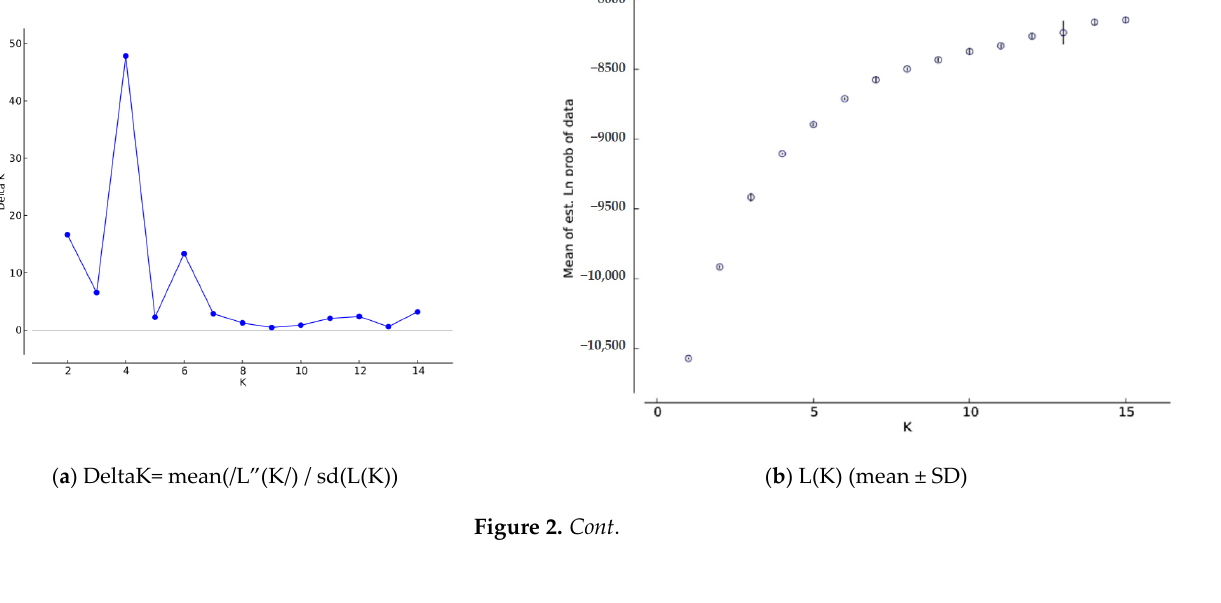
Figure 2 . Detecting the most likely number of genetically distinct groups within yellow-bellied toads in the northern Weser Hills based on ( a ) mean L(K) ± SD over 20 runs per K, ( b ) Maximum likelihood estimation of K [30] and ( c ) percentage of population assignment of K = 4. Each individual is visualized as a single line. Coloration indicates the membership of the individual to the given cluster (“G”). G1 (orange) = FL, WW, NS, BO, SM, MB. G2 (green) = WE, LI, JW, BE, RO, SH. G3 (blue) = BM, BH. G4 (purple) = PA. G4 was very clearly demarcated against all other clusters, with PA being the only study site within this cluster. LI and other study sites around Bückeberg showed no dis- tinct separation, but rather a mixture between cluster G1 and G2. The pairwise F ST ranged from 0.01 to 0.33 (Supplementary Materials Table S4), with a global F ST of 0.1. PA showed